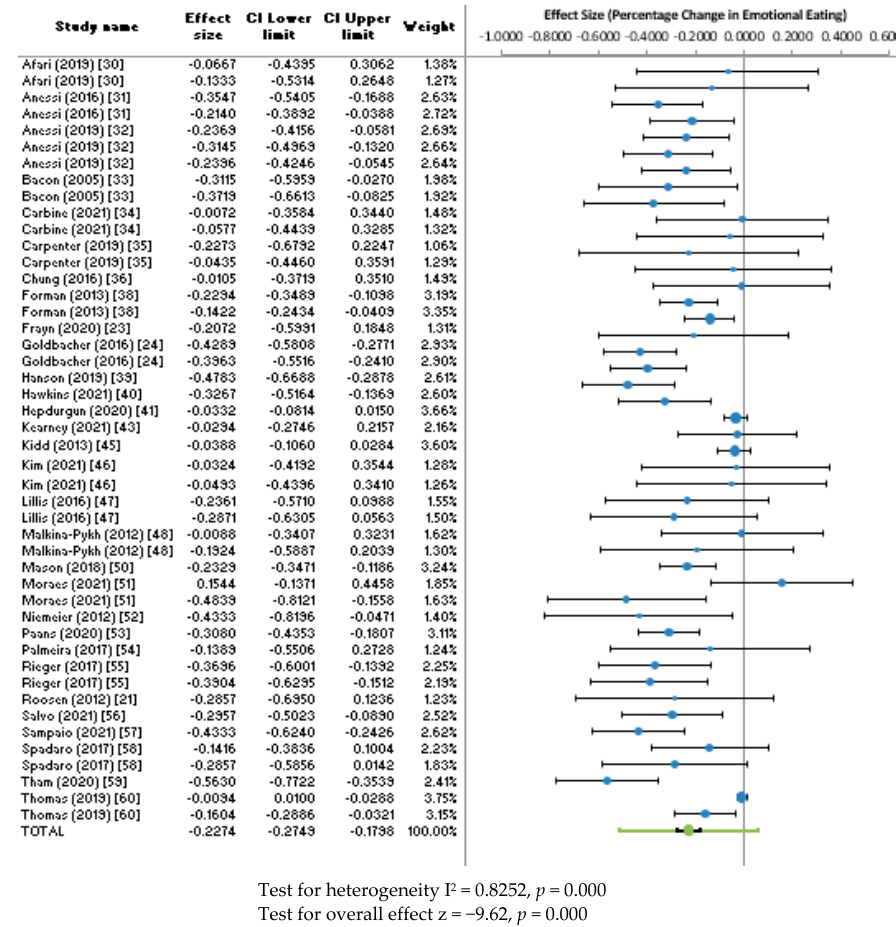
Figure 3. Funnel plot for effect size against standard error for percentage weight change.